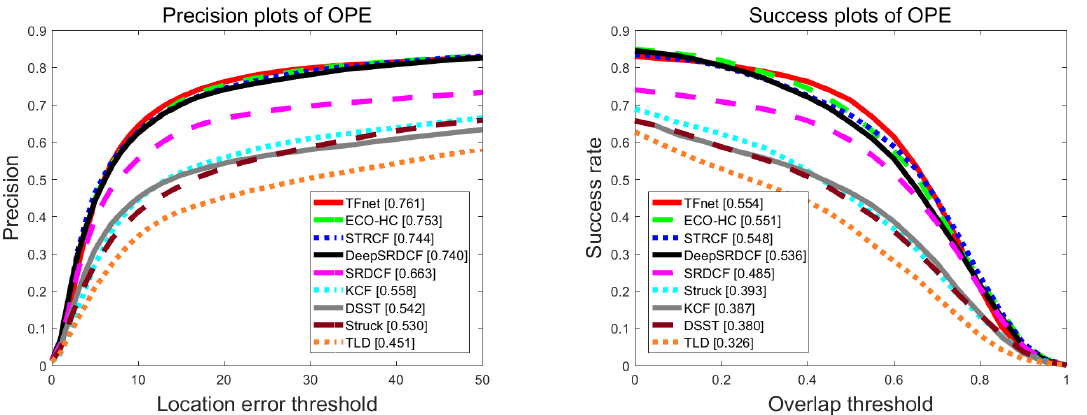
Figure 7. Distance precision plot and overlap success rates plot using one-pass evaluation on the TC128